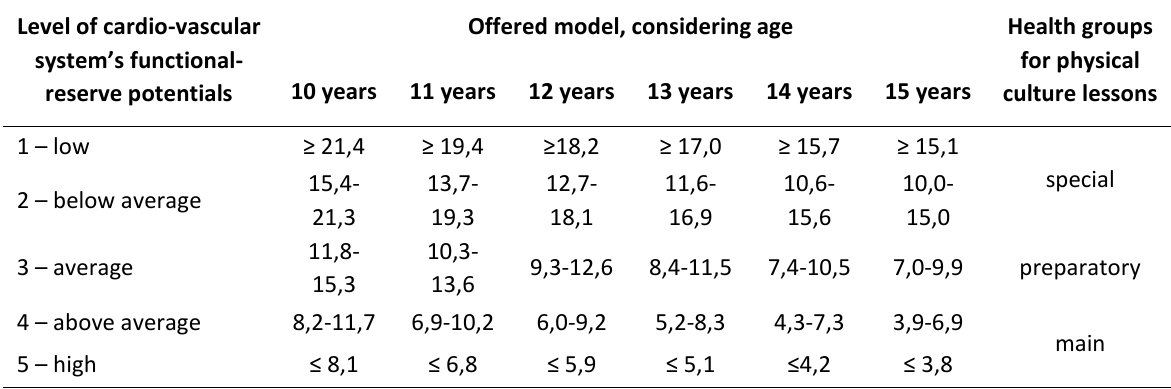
Table 1. Gradation of levels of cardio-vascular system’s functional reserve for secondary school age pupils (by